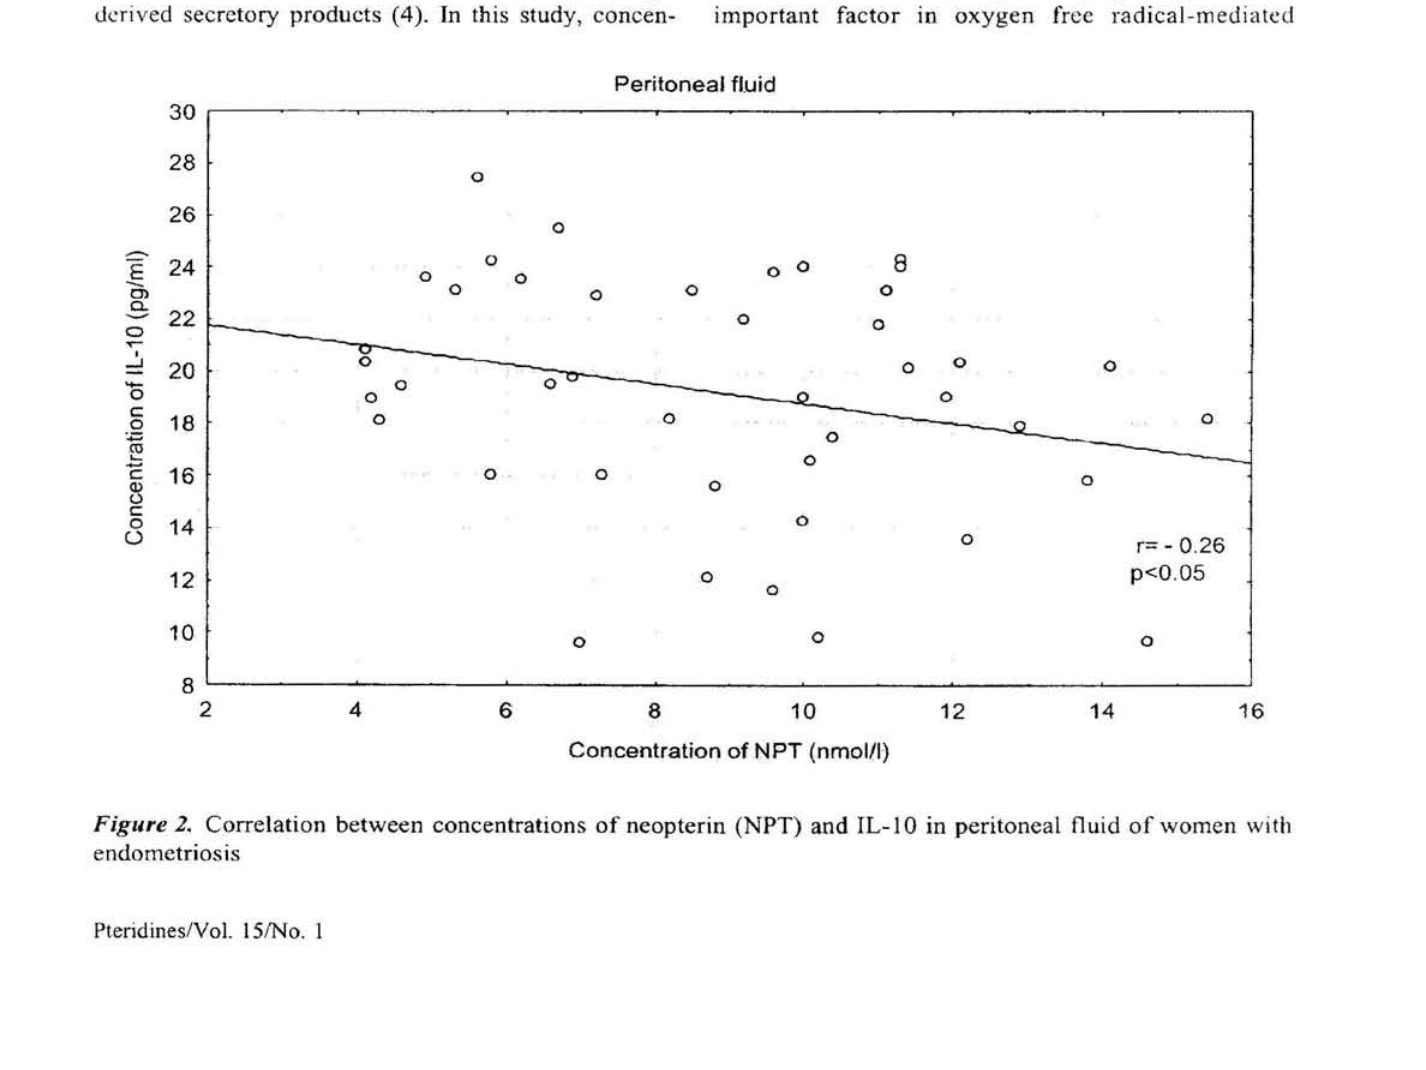
Figure 2. Correlation between concentrations of neopterin (NPT) and IL-10 in peritoneal fluid of women with endometriosis